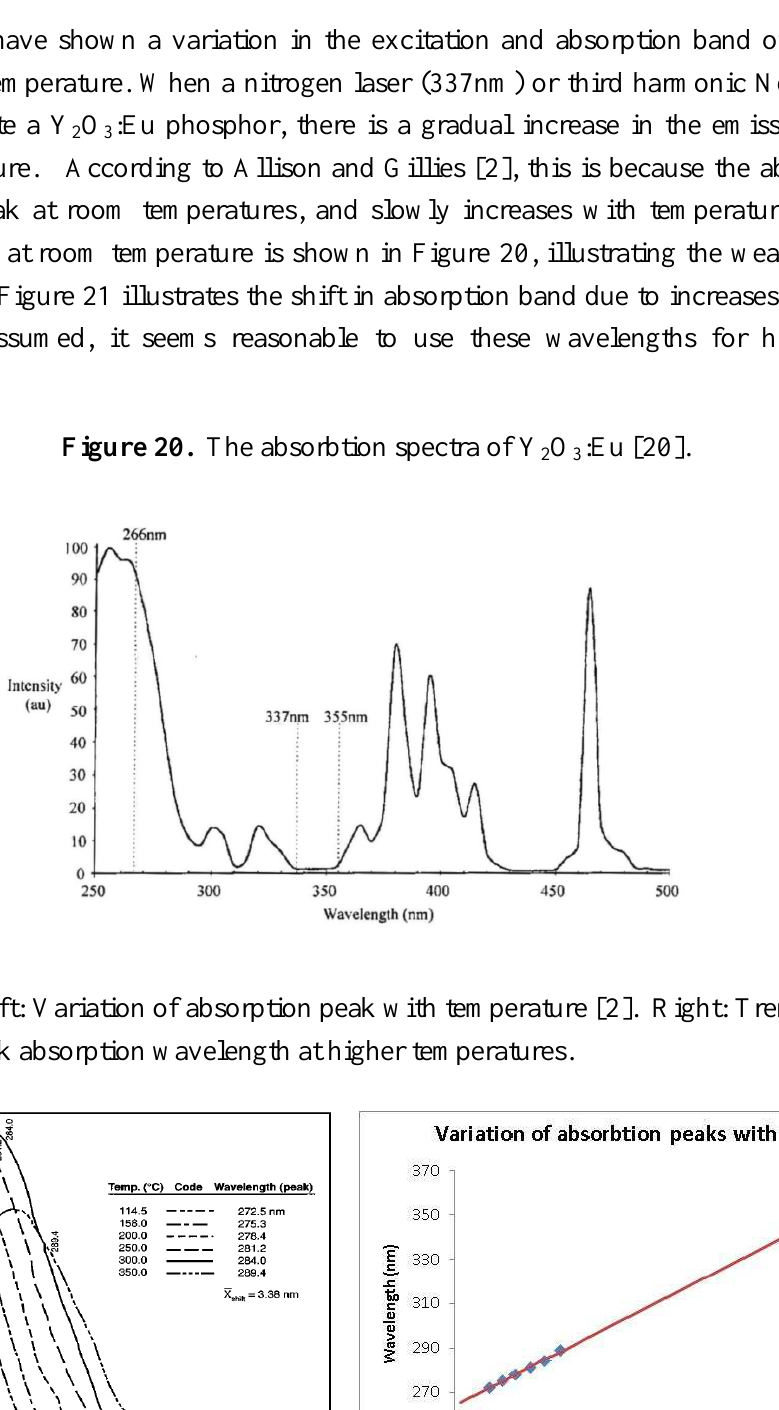
Figure 20. The absorbtion spectra of Y